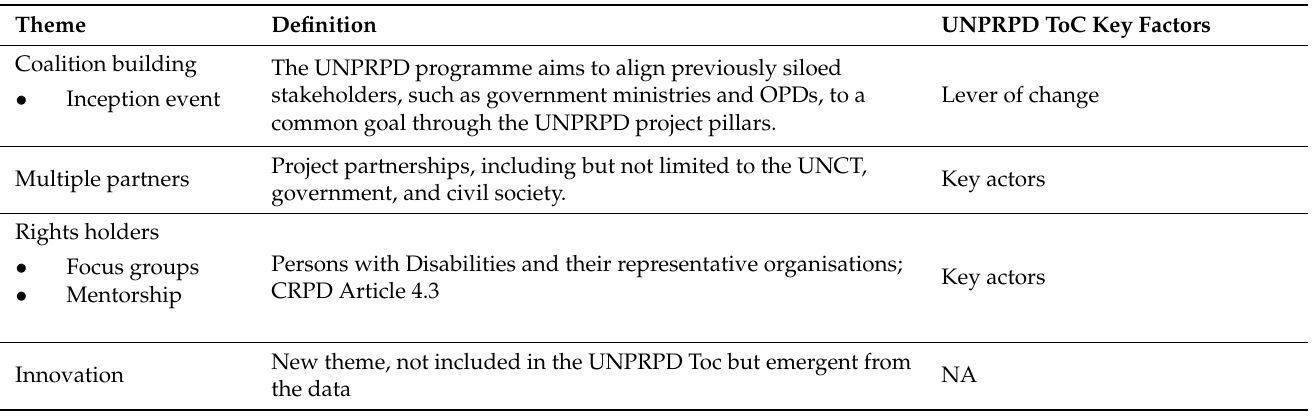
Table 2. Research findings categorical definitions against the key factors in the UNPRPD